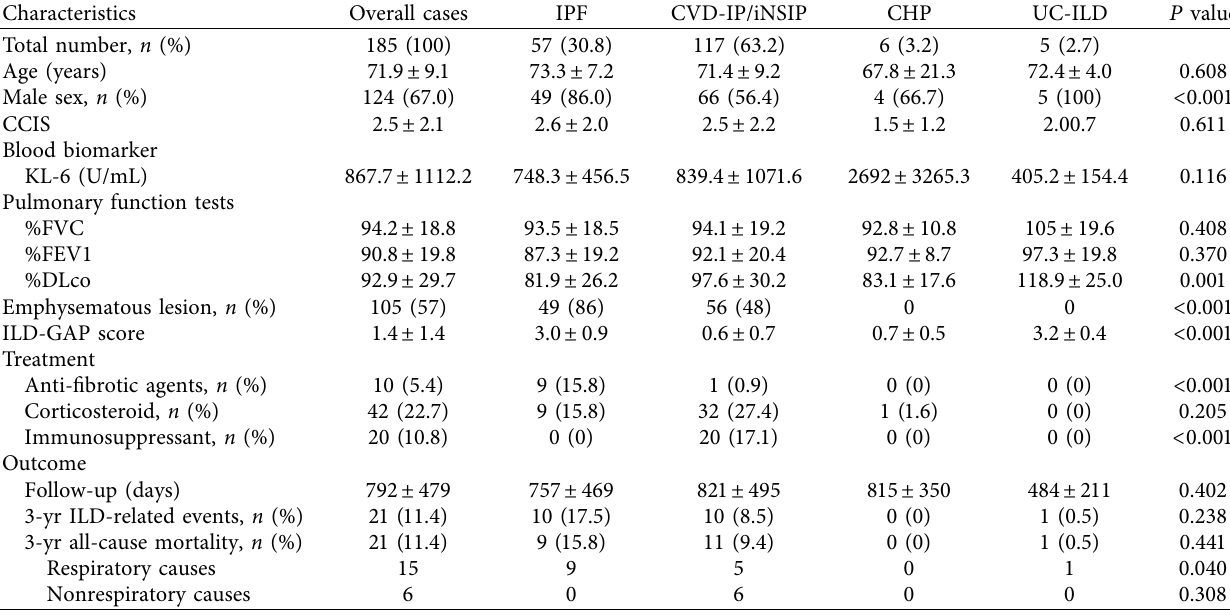
Table 2: Patient’s